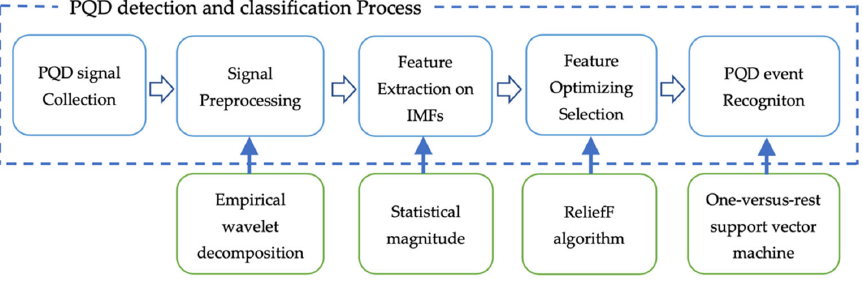
Figure 2. Main flowchart of the proposed